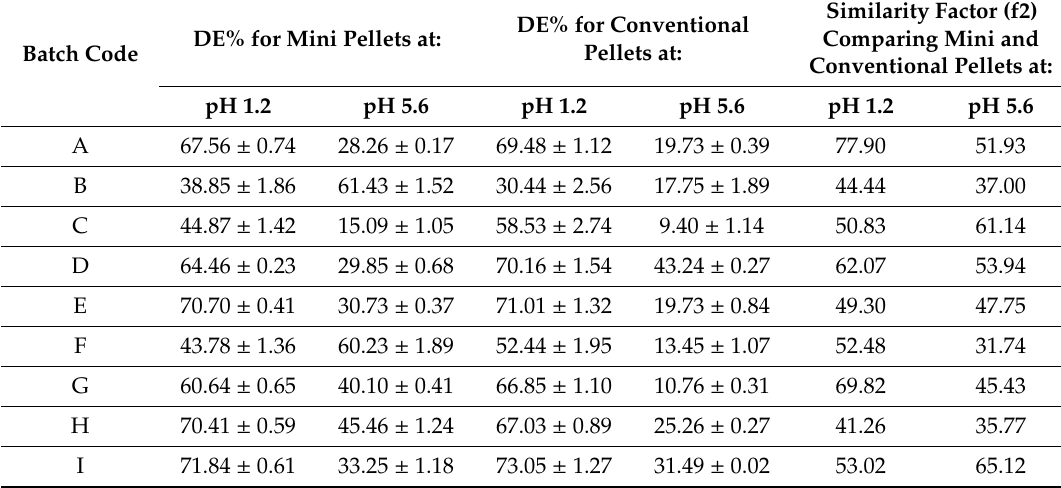
Table 7. Dissolution e ffi ciency (DE%) (mean ± SD, n = 3) and similarity factors (f2) comparing drug release from mini and conventional pellets at pH 1.2 and 5.6. Similarity Factor (f2) DE% for Conventional Comparing Mini and DE% for Mini Pellets at: Pellets at: Batch Code Conventional Pellets